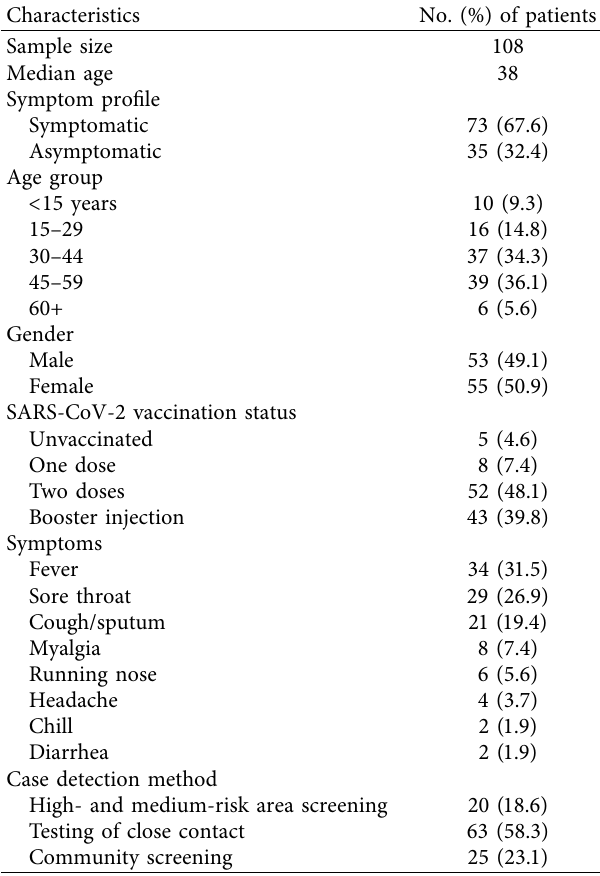
Table 1: Demographic and epidemiological characteristics of cases with SARS-CoV-2 Omicron variant in Beichen district, Tianjin,